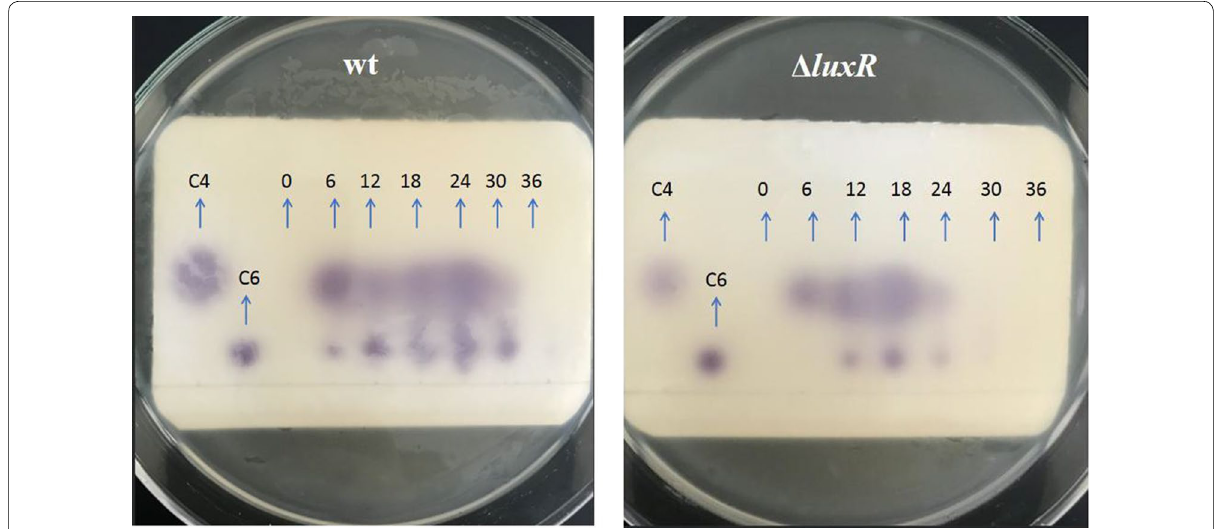
Fig. 1 TLC bioassay of AHLs produced by H. alvei H4 wt and Δ luxR with C. violaceum CV026 as a sensor strain. Lane 1: C4-HSL standard AHL; Lane 2: C6-HSL standard AHL; Lane 3–Lane 9: 0–36 h every 6 h of AHL extracted from H. alvei H4 wild type and mutant strain culture